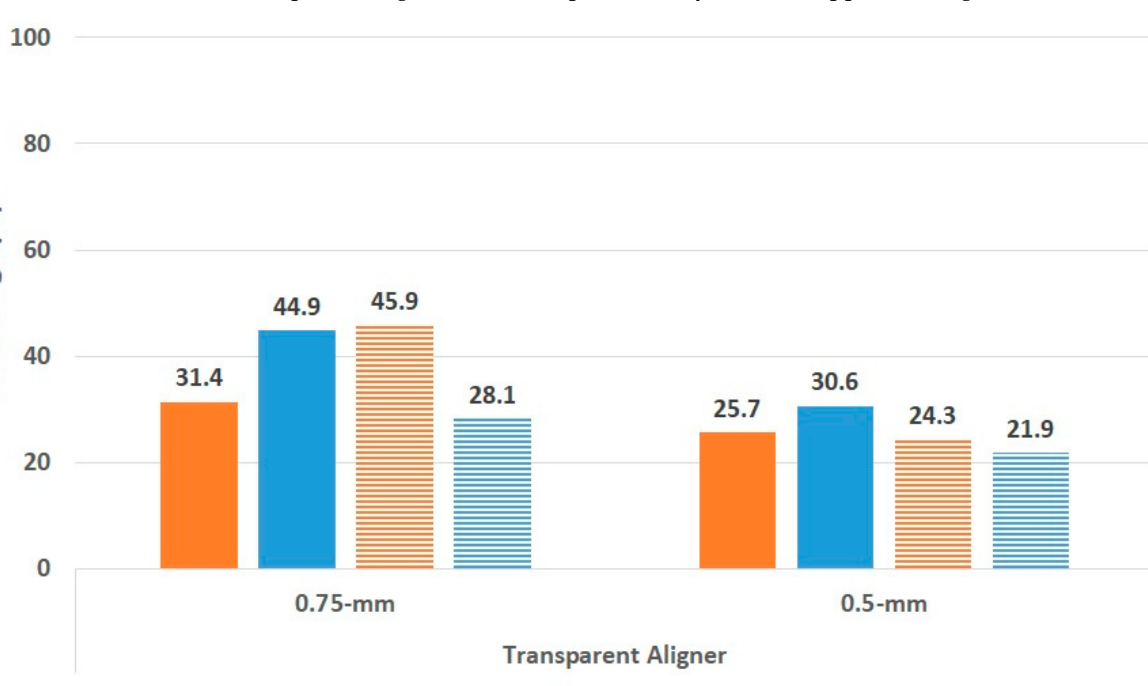
Figure 14. Movement of central incisor in the finite elements analysis of orthodontic treatment. 3.2.2. Principal Stress of the Periodontal Ligament and Alveolar Bone We compared orthodontic treatment for lingual inclination and axial rotation of central incisors by comparing the principal stresses of the PDL and alveolar bone produced by the transparent aligners with that produced by the fixed appliance (Figures 15 and 16).